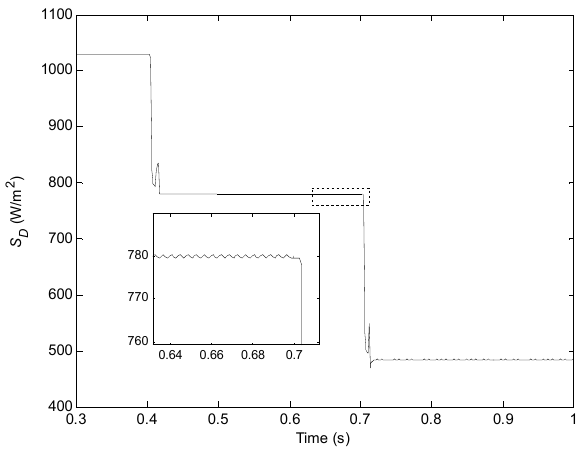
Figure 15. S curve in first simulation. Figure 15. S D curve in first D